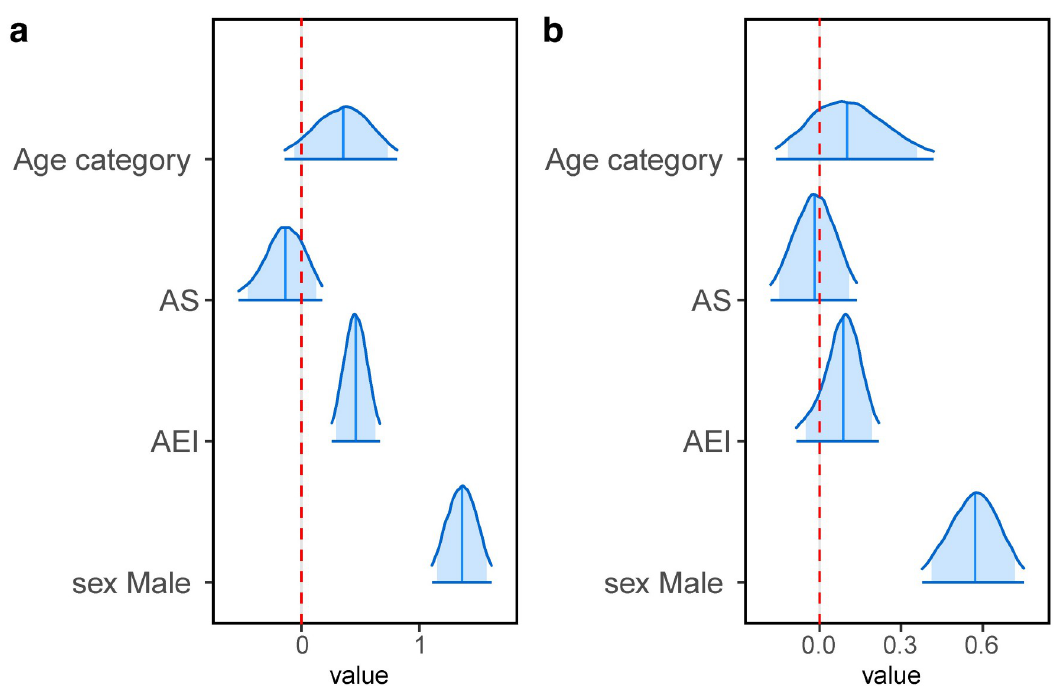
Fig 4. Posterior densities of each parameter in the transition model. 95% of posterior distributions are drawn here. The edges of distributions indicate the lower bound of 2.5% and upper bound of 97.5%. The dark blue vertical lines indicate the median. The dark blue area in each distribution shows the high density interval (HDI) which includes 89% of samples. The red dashed line indicates zero.